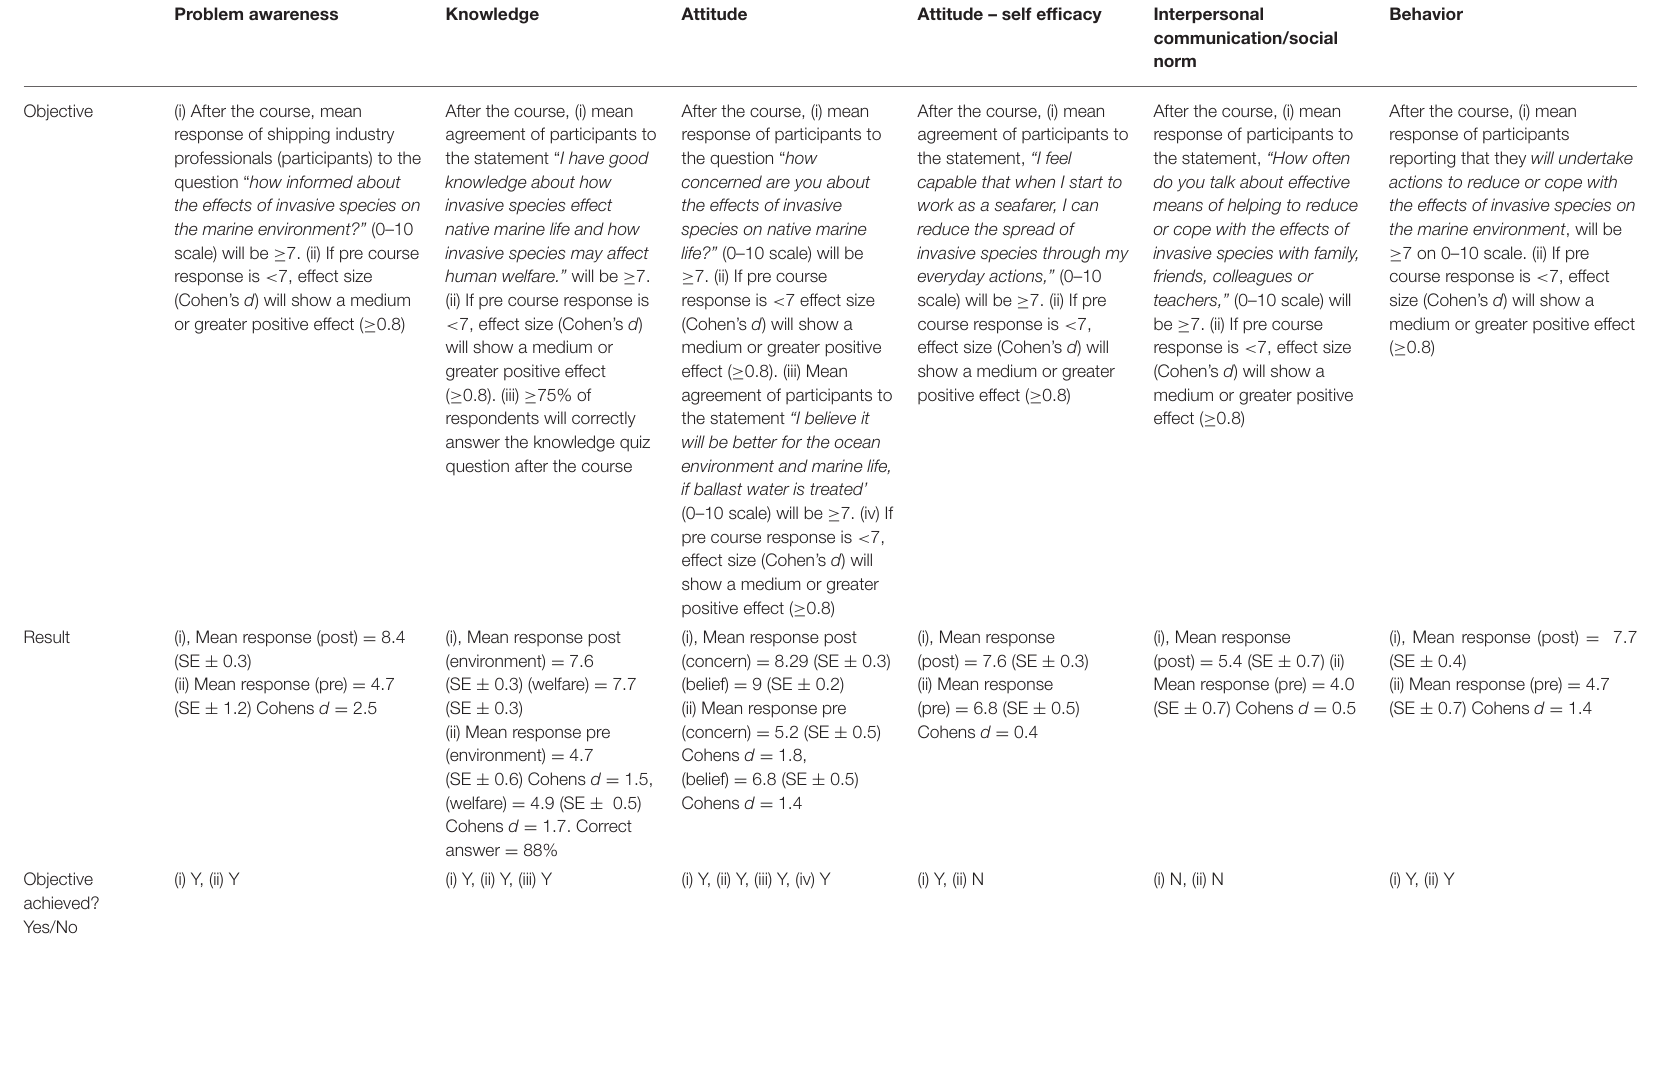
TABLE 5 | Summary of results of pre ad post surveys in relation to objectives within the “Sustainable Seafaring” course theory of